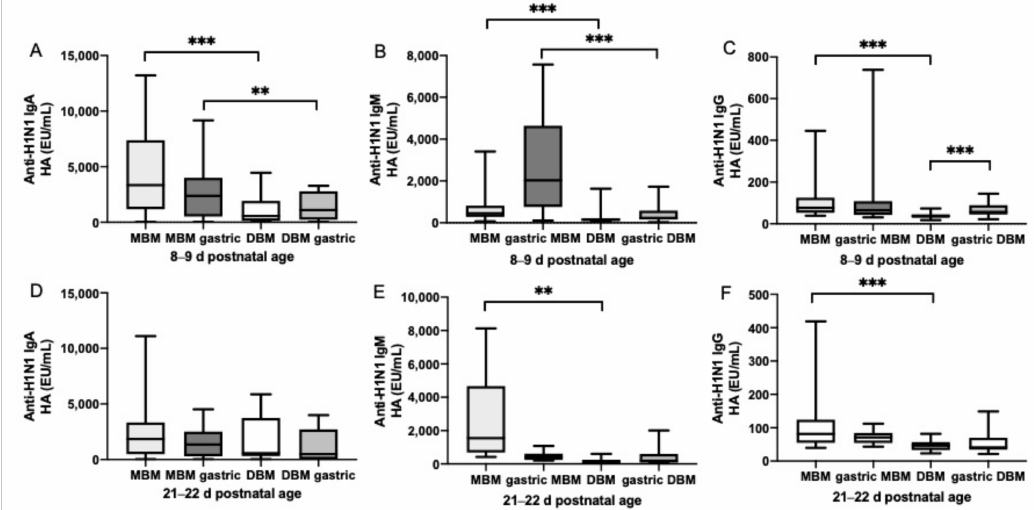
Figure 2. Milk antibodies specific to anti-H1N1 hemagglutinin (anti-H1N1 HA) in mother’s own breast milk (MBM) and donor breast milk (DBM) feeds, and gastric samples from preterm infants fed MBM and DBM (26–36 wk of GA). Relative abundance of ( A ) anti-H1N1 HA IgA, ( B ) anti-H1N1 HA IgM, and ( C ) anti-H1N1 HA IgG at 8–9 days of postnatal age. Relative abundance (EU / mL) of ( D ) anti-H1N1 HA IgA, ( E ) anti-H1N1 HA IgM, and ( F ) anti-H1N1 HA IgG at 21–22 days of postnatal age. Values are min, max, and median, n = 20 for 8–9 days and n = 16 for 21–22 days of postnatal age. Asterisks show statistically significant di ff erences between variables (*** p < 0.001; ** p < 0.01) using the Wilcoxon matched-pairs signed-rank